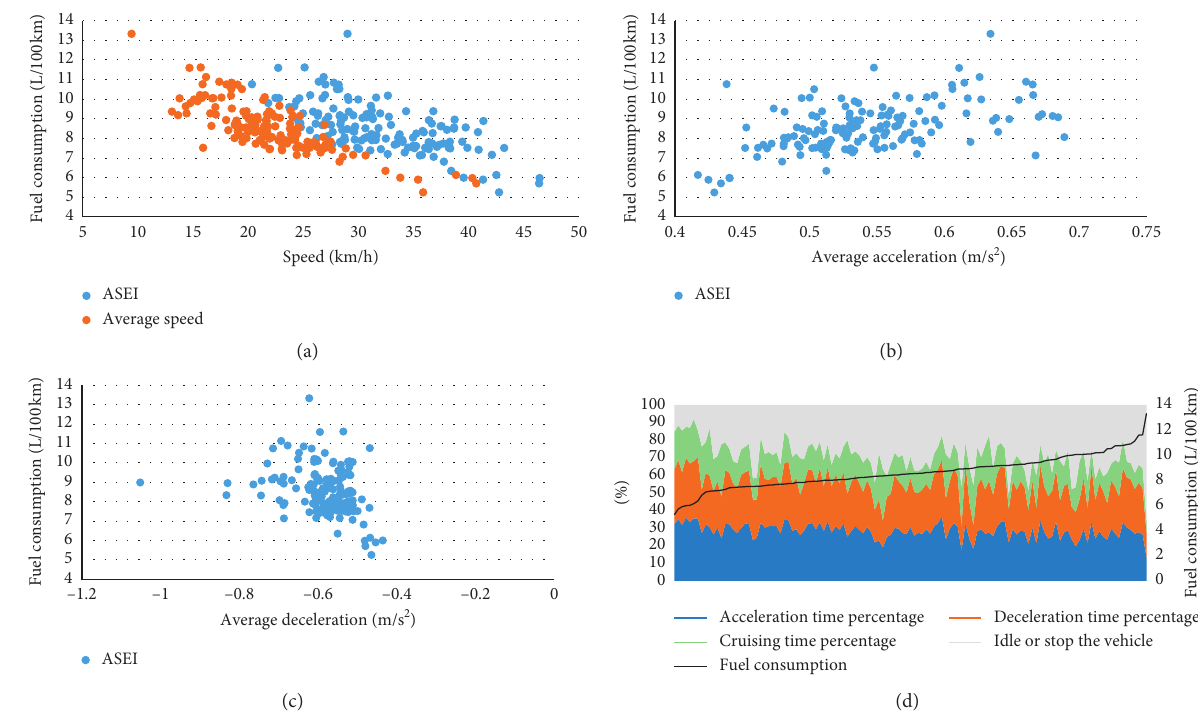
Figure 5: Fuel consumption distribution based on different driving behavior indexes. (a) The relationship between average speed and fuel consumption. (b) The relationship between average acceleration and fuel consumption. (c) The relationship between average deceleration and fuel consumption. (d) The relationship between time percentage and fuel consumption.